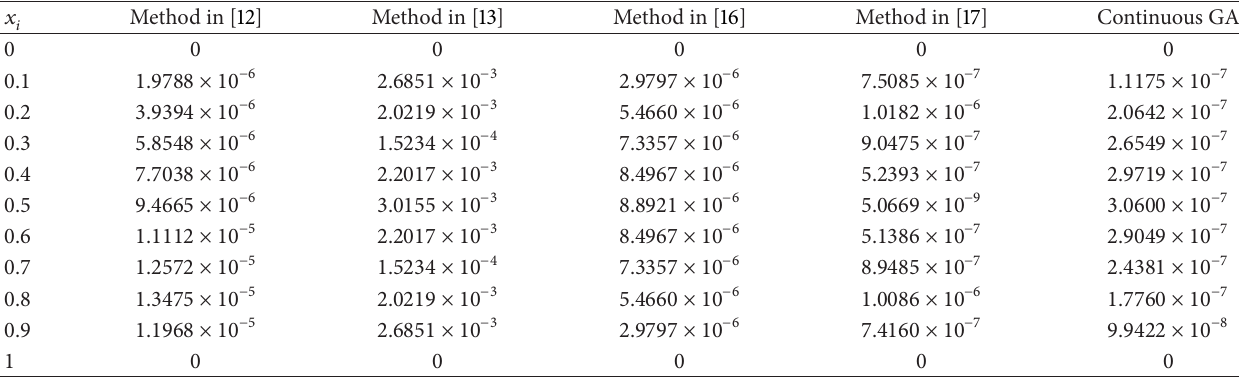
Table 7: Absolute error results for Bratu’s problem when 𝜇 = 1 .